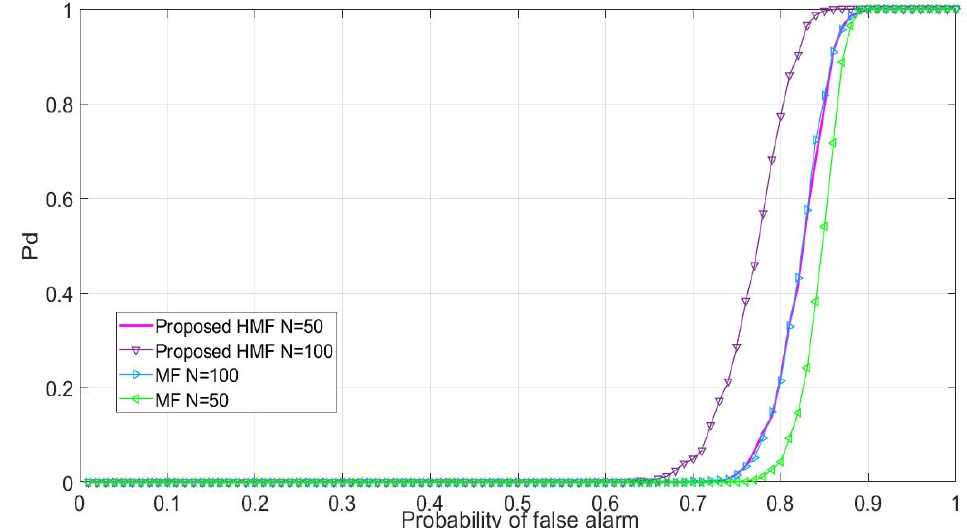
Figure 7. Performance of probability of detection and probability of false alarm for HMF and MF, considering number of samples = 50 and 100 in the Rician Channel.